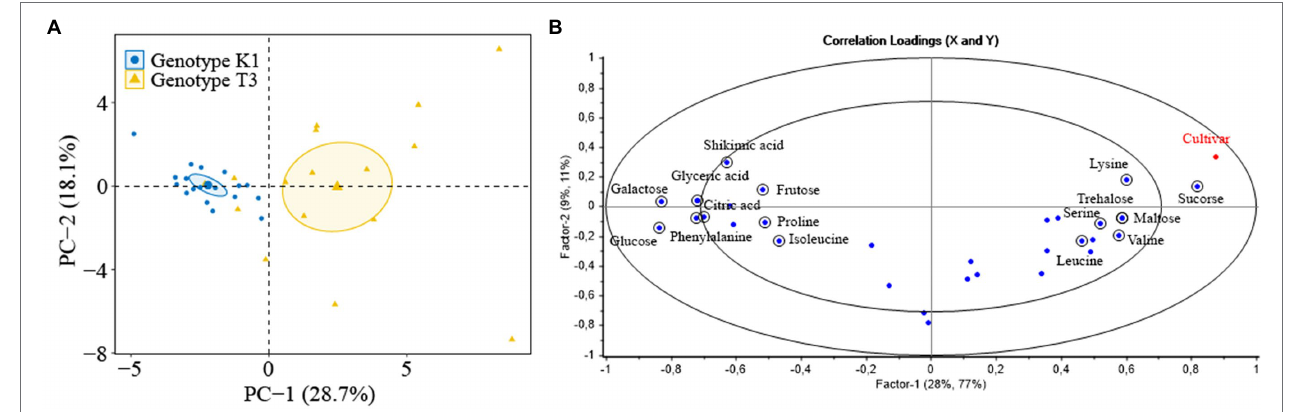
FIGURE 11 | (A) PCA score plot of primary metabolites of strawberry leaves of Kreuzkogel 1 (K1) and Tenno 3 (T3). One dot represents one strawberry leaf, and PC-1 and PC-2 refer to the first and the second factor used to explain the variance. (B) Correlation loading plots of PLSR analysis with the primary metabolite profile of strawberry leaves of K1 and T3 as variables and cultivar (category) as response. The outer ellipse indicates 100% of explained variance, while the inner ellipse indicates 50% of explained variance. One blue dot represents one specific metabolite (X-factor), and encircled metabolites contributed to the separation of two genotypes which selected by jack-knifing test. The red dot represent the category cultivar (Y-factor).